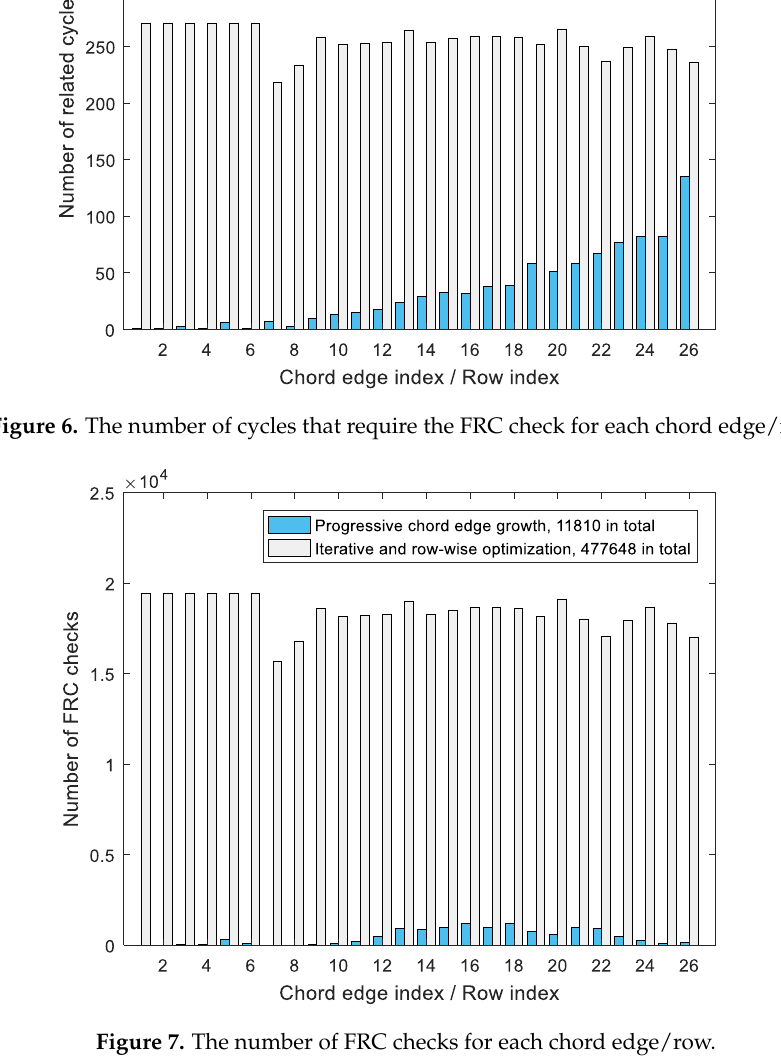
Figure 7. The number of FRC checks for each chord